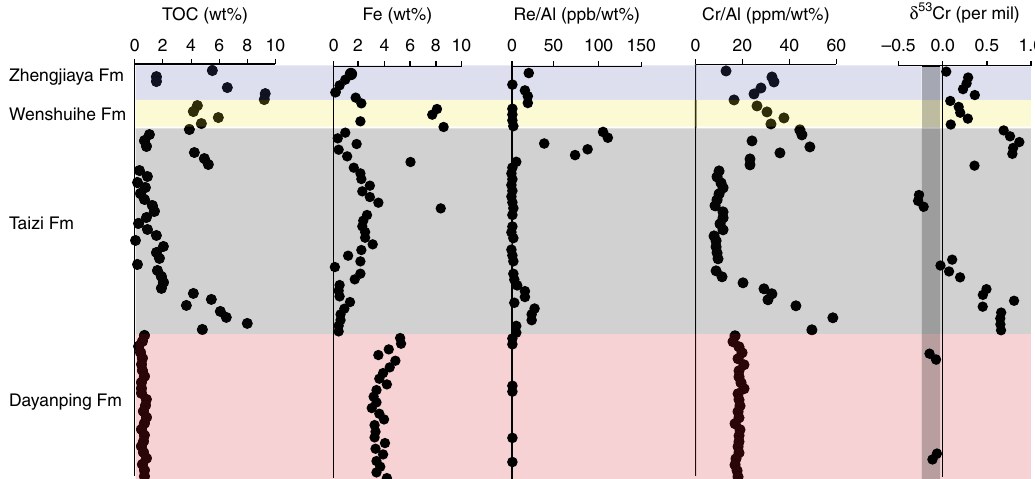
Fig. 4 The isotopic composition of chromium ( δ 53 Cr) compared with organic carbon (TOC) concentration, Fe concentration, Re/Al, and Cr/Al. As in Fig. 3, samples are plotted sequentially and relative to stratigraphic position (from top to bottom), but not as function of exact stratigraphic position. The gray vertical bar in the δ 53 Cr plot represents the crustal average value 39